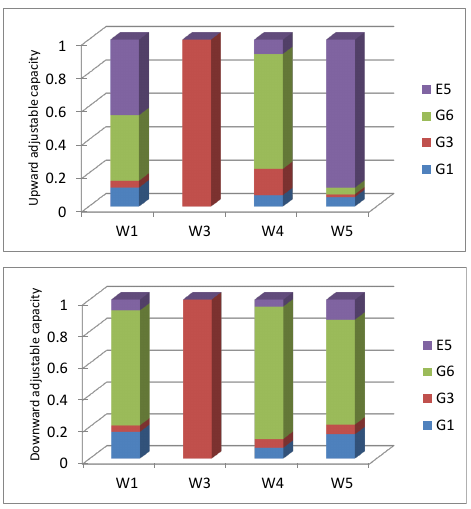
Figure 3. Upward and downward adjustable coefficients of dispatchable generators and energy storage to accommodate wind power.